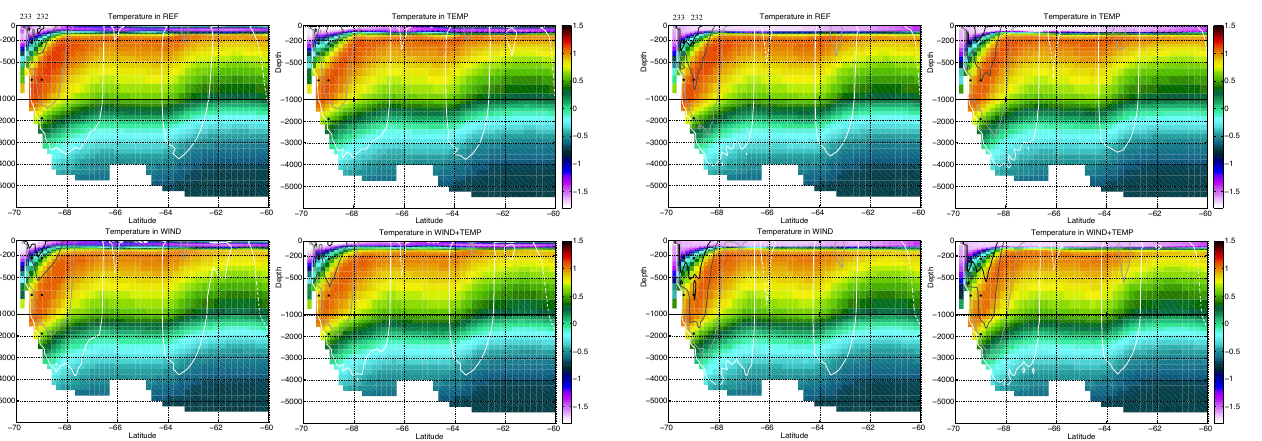
Fig. 7. Section at 0 ◦ E in simulations TEMP, REF, WIND and WIND + TEMP during January. Colors represent the tempera- ture (in ◦ C) and solid lines represent the zonal current (1cms − 1 is in white, 5cms − 1 is in light grey, 10cms − 1 is in dark grey line, dashed lines correspond to eastward velocity). The white area cor- responds to the ocean floor. Notice that the vertical scale is not linear; a zoom is done on the first 1000m. Black dots show the moorings AWI 233 and 232 used in Figs. 9 and 10.